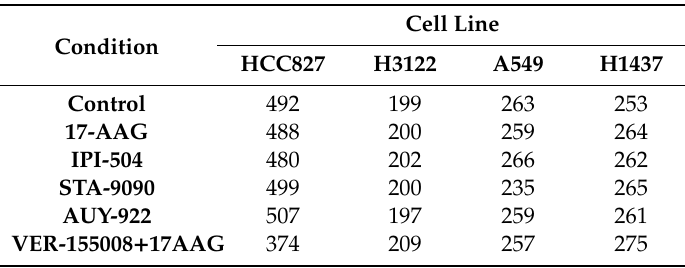
Number of matched protein spots in the considered cell lines under the di ff erent treatment conditions.